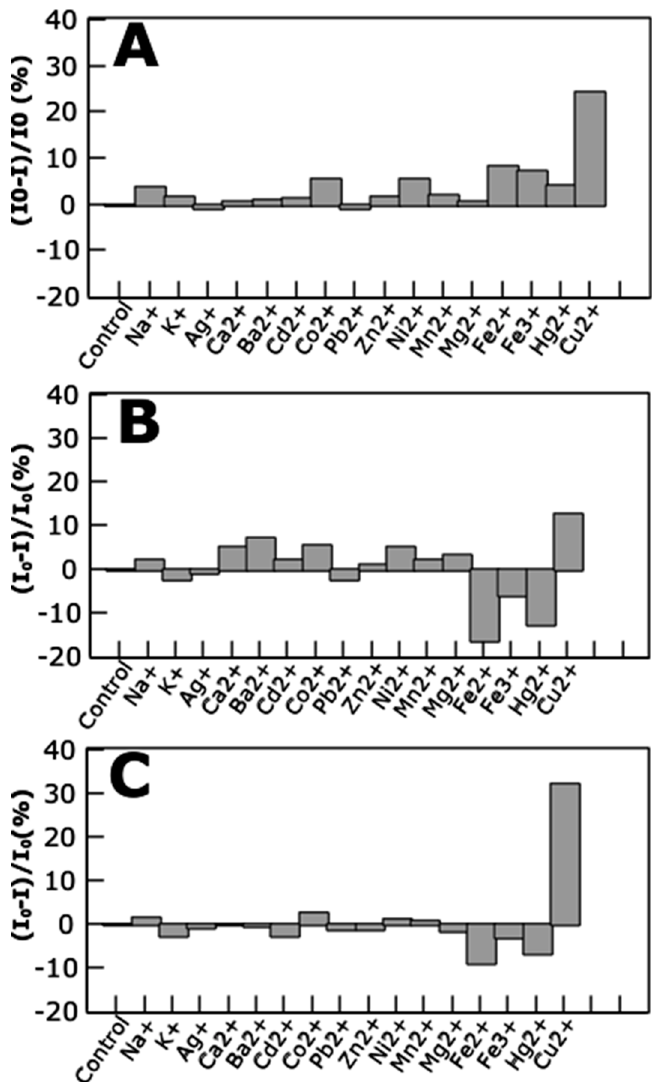
Figure 5. Ion detection by protein-stabilized NCs. The change in the fluorescence emission intensity of the protein-stabilized nanoclusters upon addition of different ions. C3_cys-CuNCs ( A ); C3_cys-AgNCs ( B ); and C3_cys-AuNCs ( C ).